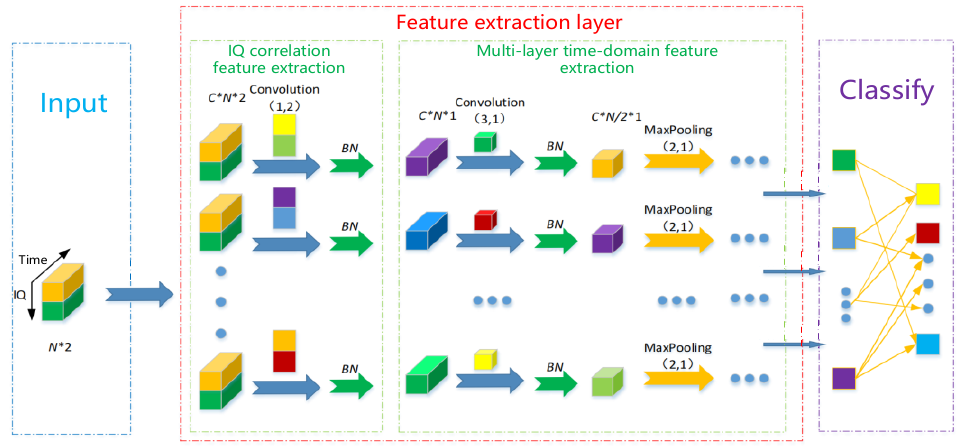
Figure 2. IQCLNet structure.